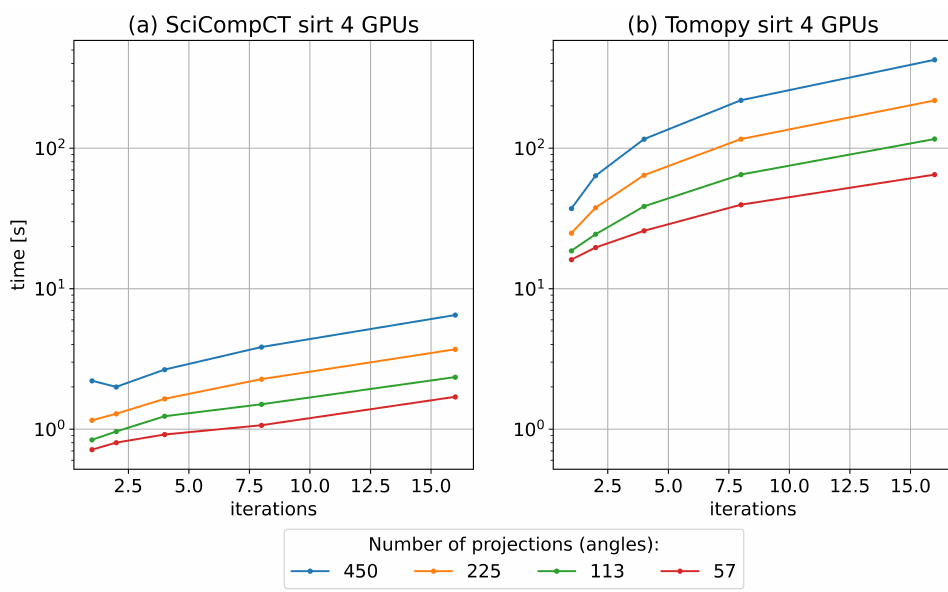
Figure 4. Tomography module (SciCompCT) processing time is measured against the multi-GPU solution in Tomopy [7]; a large dataset of (angles × 1024 × 1024) is automatically sliced among n = 4